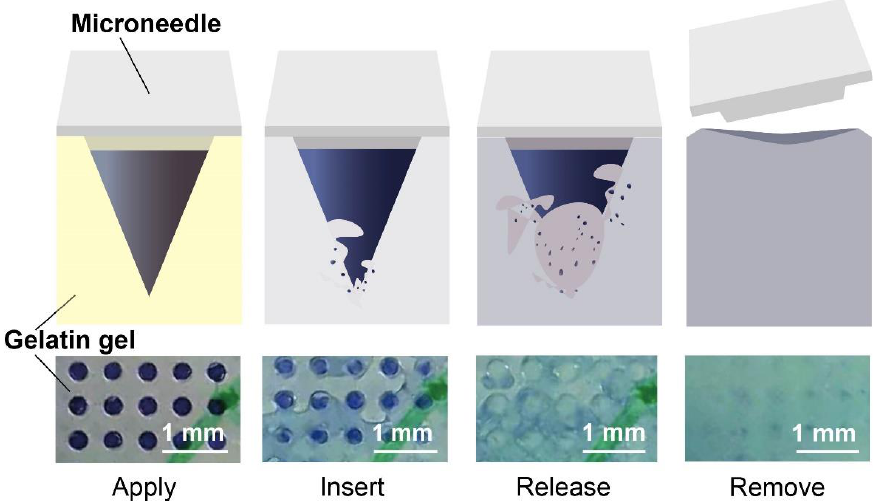
Figure 4. The process of application, insertion, release, and removal of microneedles. The pictures at the top show the schematic of the change of the tip. The pictures at the bottom show the change on the gelatin gel after inserting microneedles.